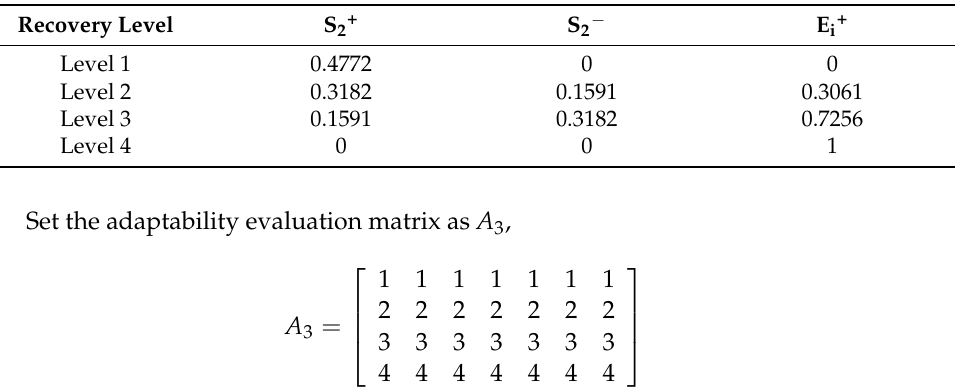
Table 12. Recovery grade standard.